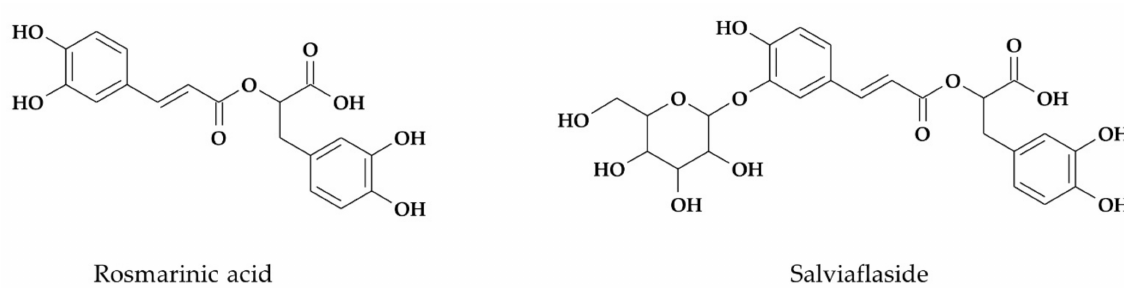
Figure 2. Chemical structures of phenolic compounds determined quantitatively in S. yangii and S. abrotanoides .